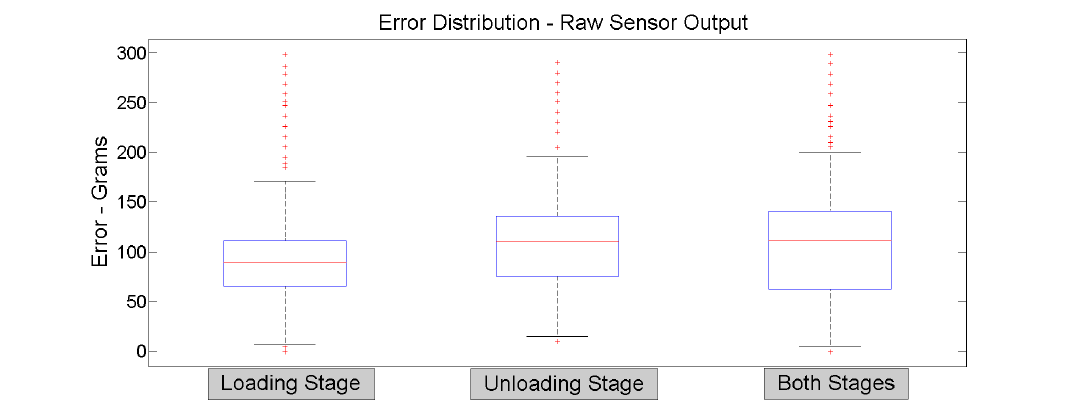
Figure 13. Raw sensor output error distribution.